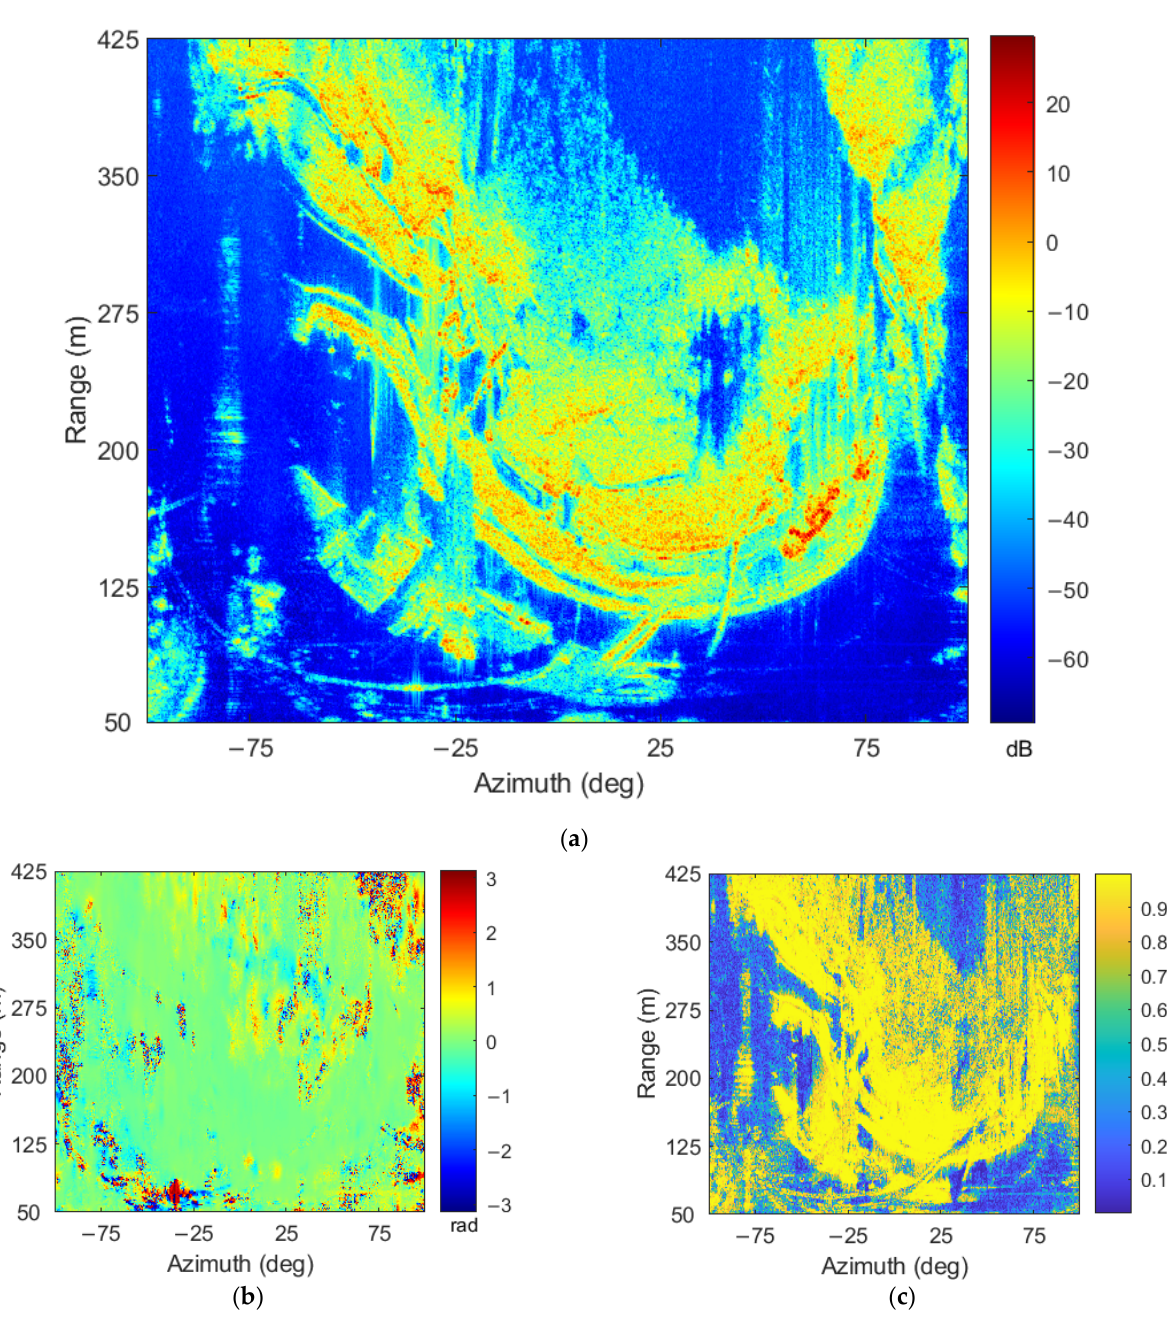
Figure 3. ( a ) Intensity image at 14:32 on 3 April 2021. ( b ) Interferogram from 14:32 to 14:37 on 3 April 2021. ( c ) Coherence coefficient image from 14:32 to 14:37 on 3 April 2021.